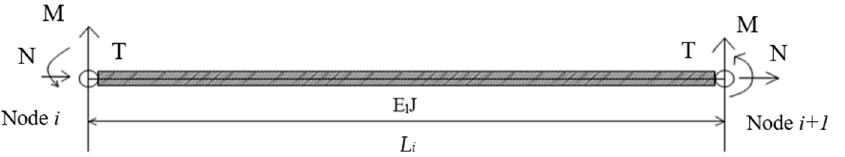
Figure 2. Beam-type finite element in the tunnel lining with reference to the local Cartesian coordi- nates ( i is initial node; i + 1 is final node; L i is element length).